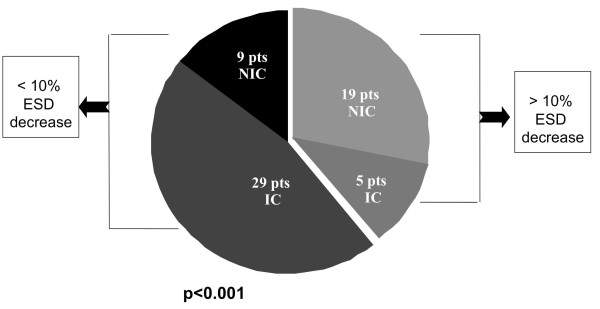
Distribution of patients according to etiology of LV dysfunction and changes in end systolic dimensions (ESD) at FU. IC: ischemic cardiomyopathy; NIC: non ischemic cardiomyopathy.